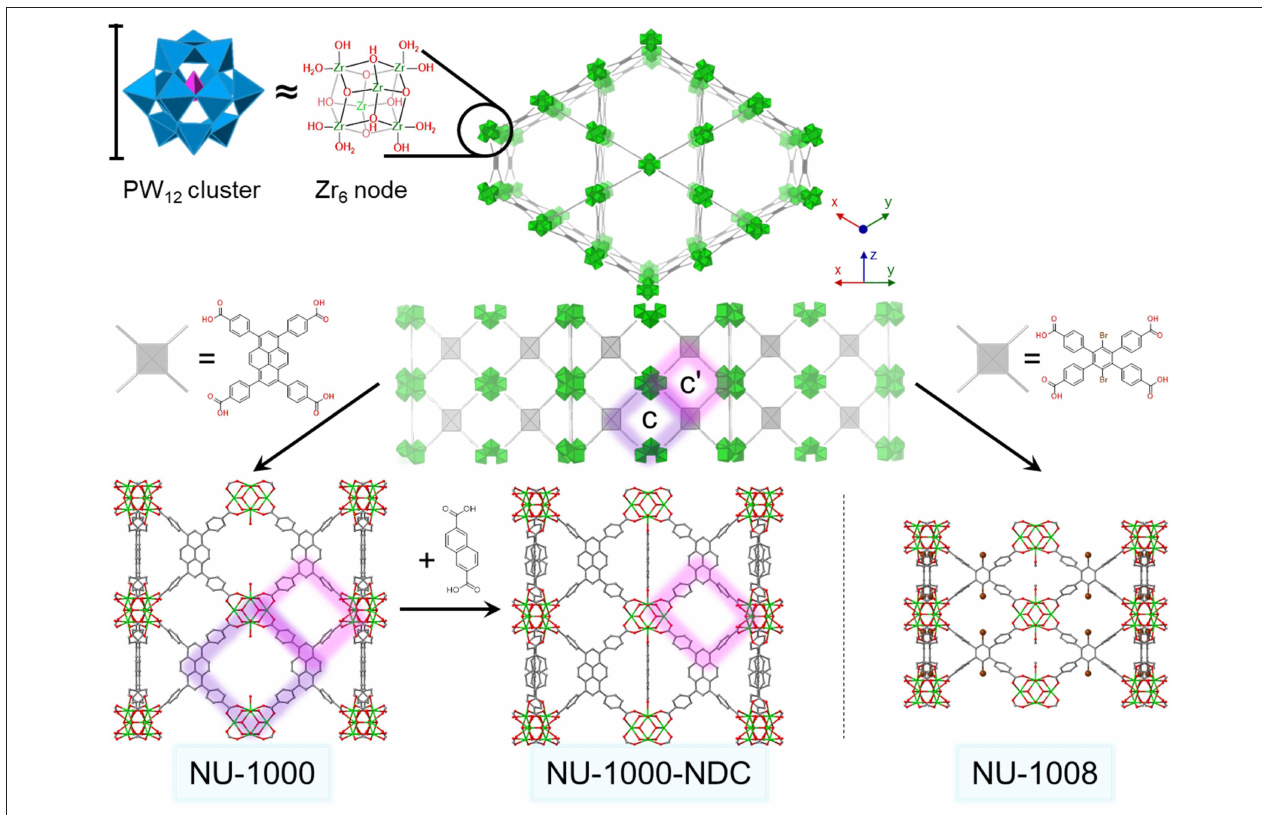
FIGURE 1 | Generic csq structure (top) viewed down the c -axis and an orthogonal view. Structures for zirconium node and size comparison to PW 12 cluster (top left). Crystal structures and structural linkers of NU-1000 (lower left), NU-1000-NDC (lower center), and NU-1008 (lower right) viewed from the ab direction. The c- and c ′ - pores are highlighted in purple and pink, respectively. For clarity, hydrogens are omitted, and one possible conformation of NDC has been extracted. Green polyhedron = Zr 6 node, blue polyhedron = WO 5 , pink polyhedron = PO 4 , green sphere = Zr, red = O, gray = C, brown =